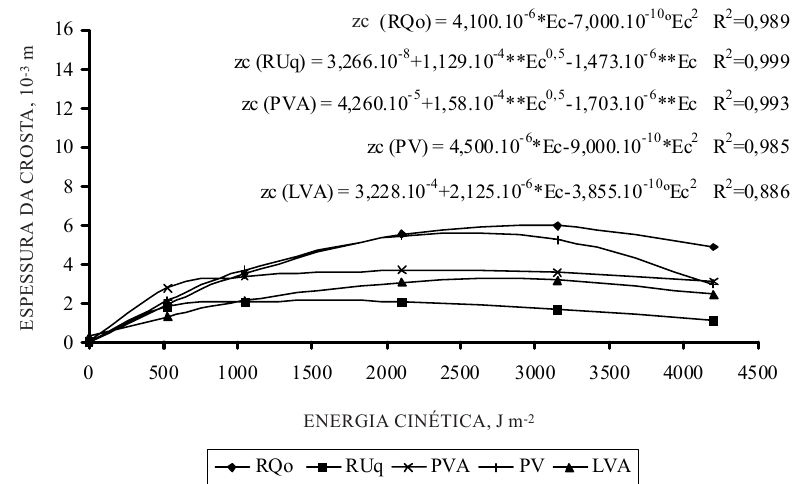
Figura 3. Espessura da crosta (zc), considerando a energia cinética aplicada (Ec) e a classe de solo (**, * e ° significativos a 1, 5 e 10 %, respectivamente, pelo teste t). Sendo: PV = Argissolo Vermelho; PVA = Argissolo Vermelho-Amarelo; LVA = Latossolo Vermelho-Amarelo; RUq = Neossolo Flúvico; e RQo = Neossolo